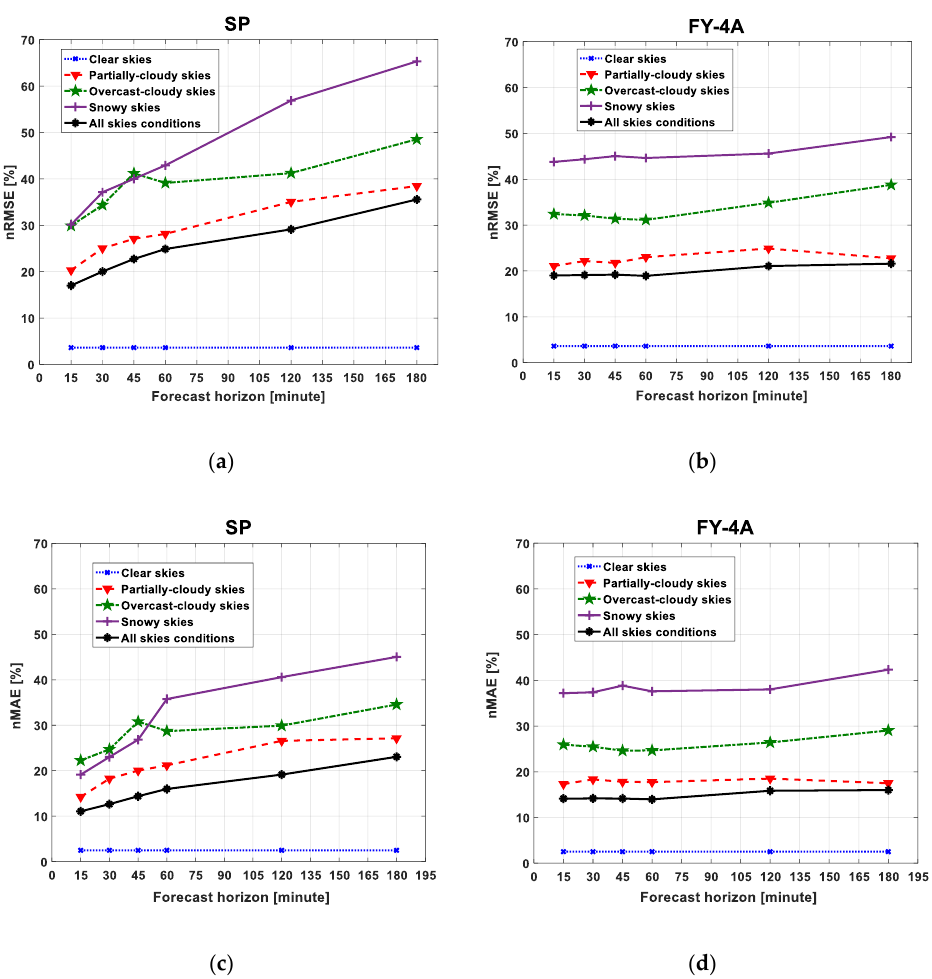
Figure 9. The nRMSE (%) and nMAE (%) under different sky conditions at different horizons: ( a ) and ( c ) SP model; ( b ) and ( d ) Model using the FY-4A satellite images.